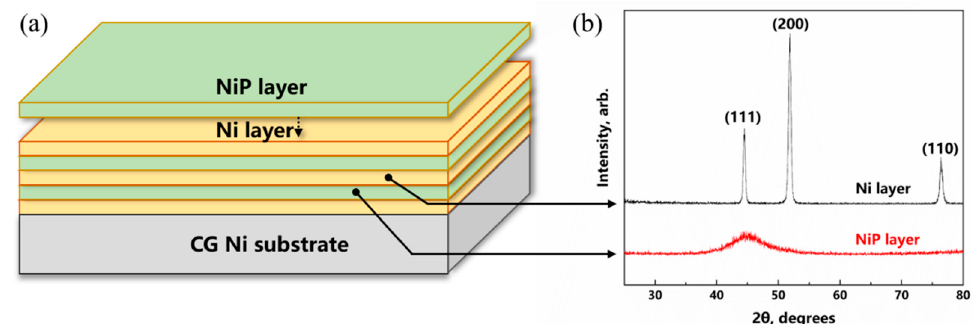
Figure 1. Schematic representation of the NiP/Ni composite coating deposited on the CG Ni substrate ( a ) and XRD patterns of the deposited NiP layer and the Ni layers ( b ).